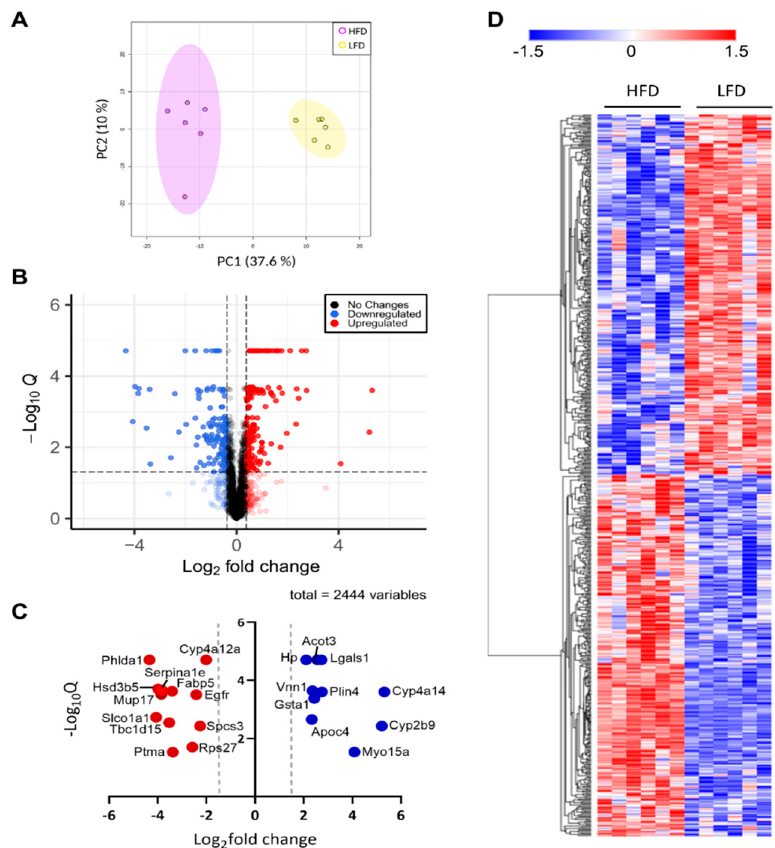
Figure 3. Global proteomic analysis. ( A ) PCA plot of significant proteins in each biological replicate. ( B ) Volcano plot of all quantified proteins. Zero q-values were converted to lowest non-zero q-value × 10 − 1 for this data representation. Blue color denotes downregulated proteins, red denotes upregulated proteins, and grey denotes proteins that do not change in response to administered diet. ( C ) Proteins with a t-test q-value < 0.05 and a |log 2 (fold-change)| > 2. Color legend is as described in ( B ). ( D ) Heatmap representation of all significant proteins clustered by hierarchical clustering. Color legend represents